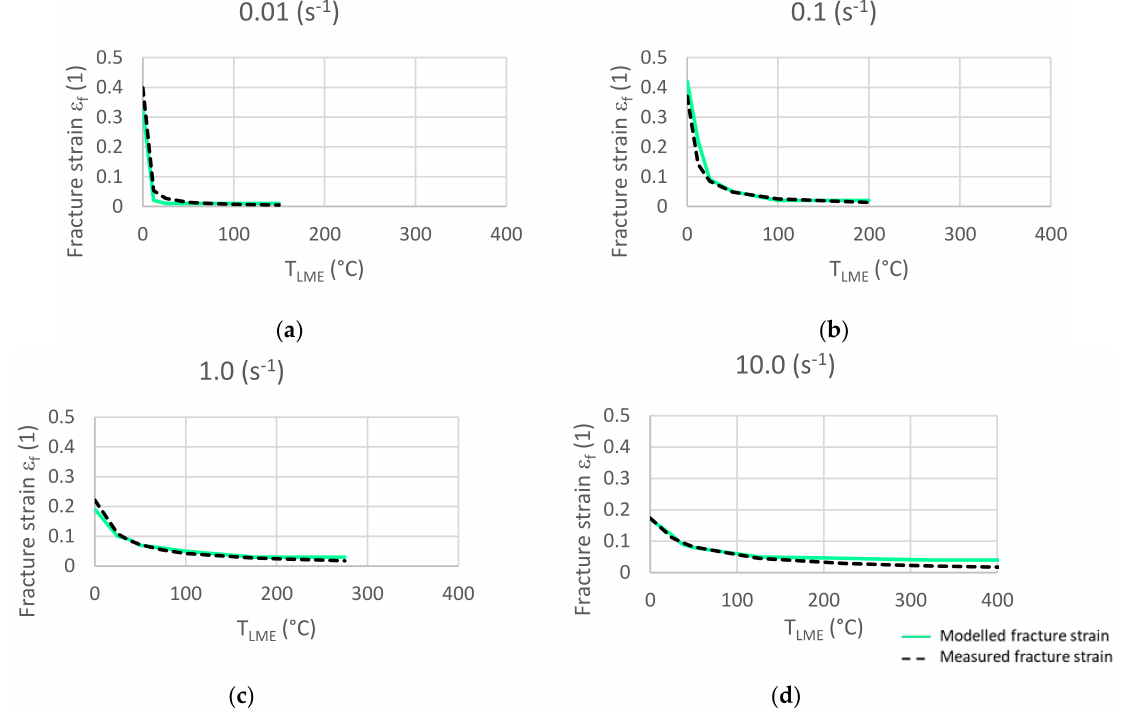
Figure 9. Comparison of modelled fracture strains (cyan solid line) vs. experimentally measured fracture strains (black dashed line) at strain rates of ( a ) 0.01 s − 1 ; ( b ) 0.1 s − 1 ; ( c ) 1.0 s − 1 and ( d ) 10.0 s − 1 as a function of T LME